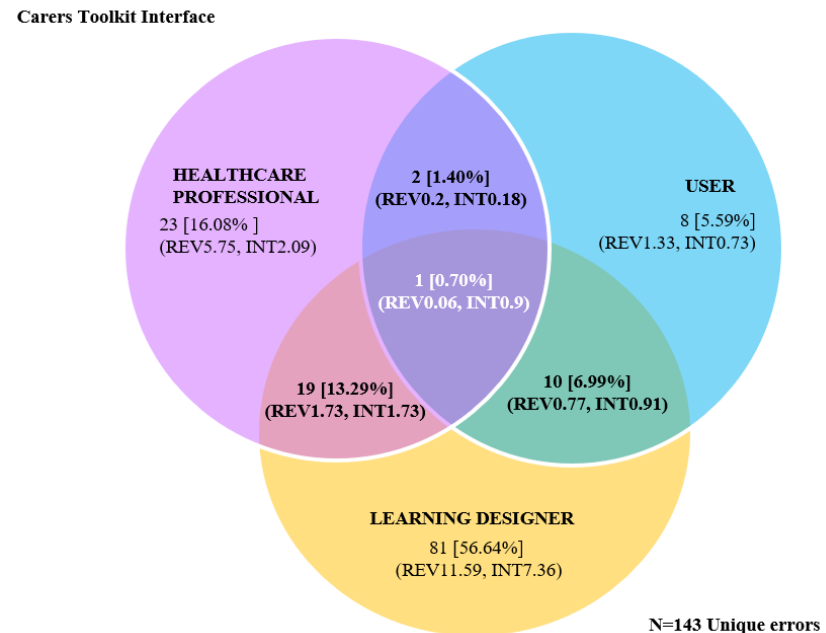
Figure 5. Unique exclusive and mutually exclusive interface errors identified between and across evaluator groups. Number of unique errors (%Total) (REV = average unique errors identified per reviewer, INT = average unique errors identified by reviewer group across the interface).